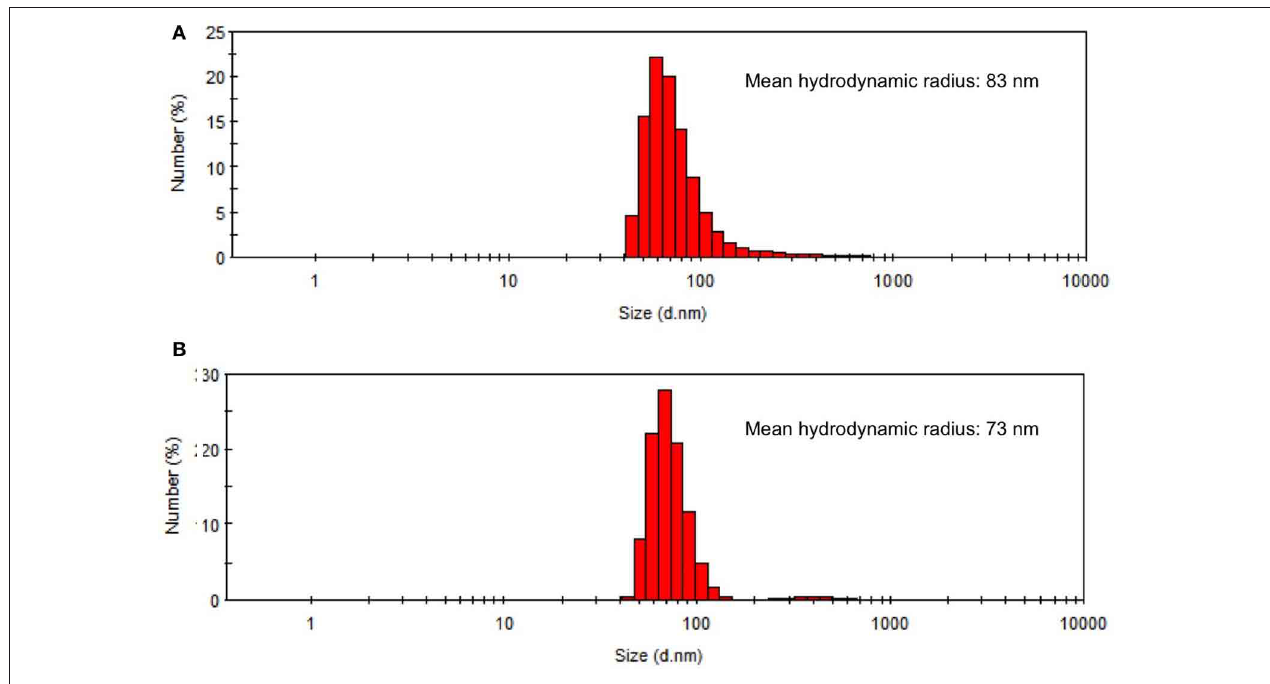
FIGURE 6 | Hydrodynamic diameter distribution of chlorosomes isolated from C. limnaeum WT cells (panel A) and the bchU mutant (panel B) as determined by dynamic light scattering. The